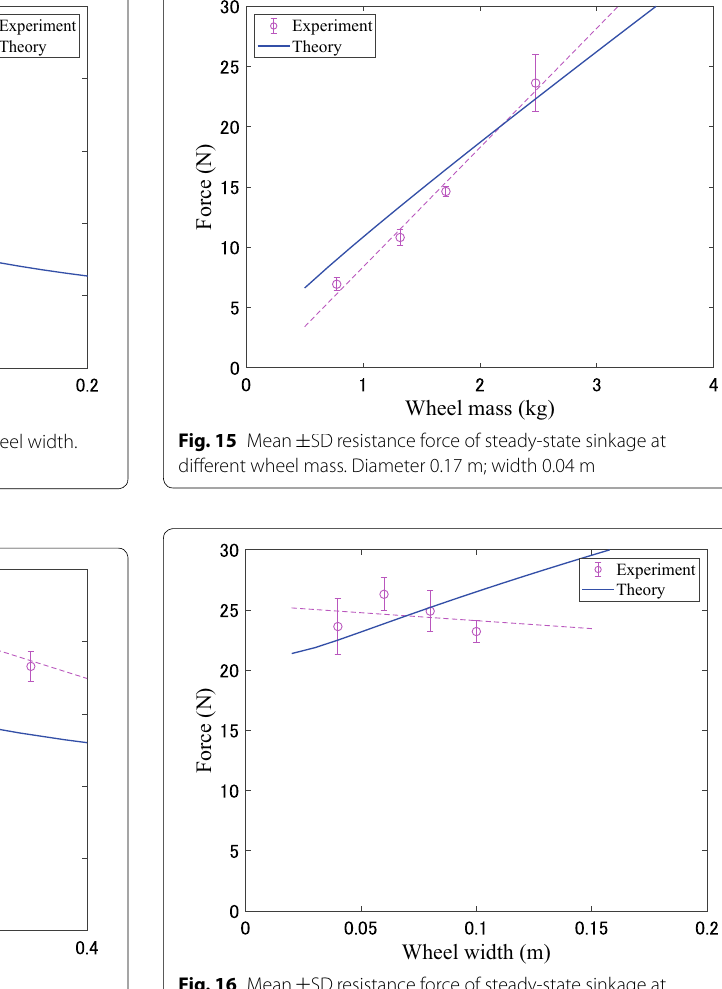
SD steady-state sinkage at different wheel diameter. Fig. 14 Mean ± Width 0.04 m; mass 2.5 kg